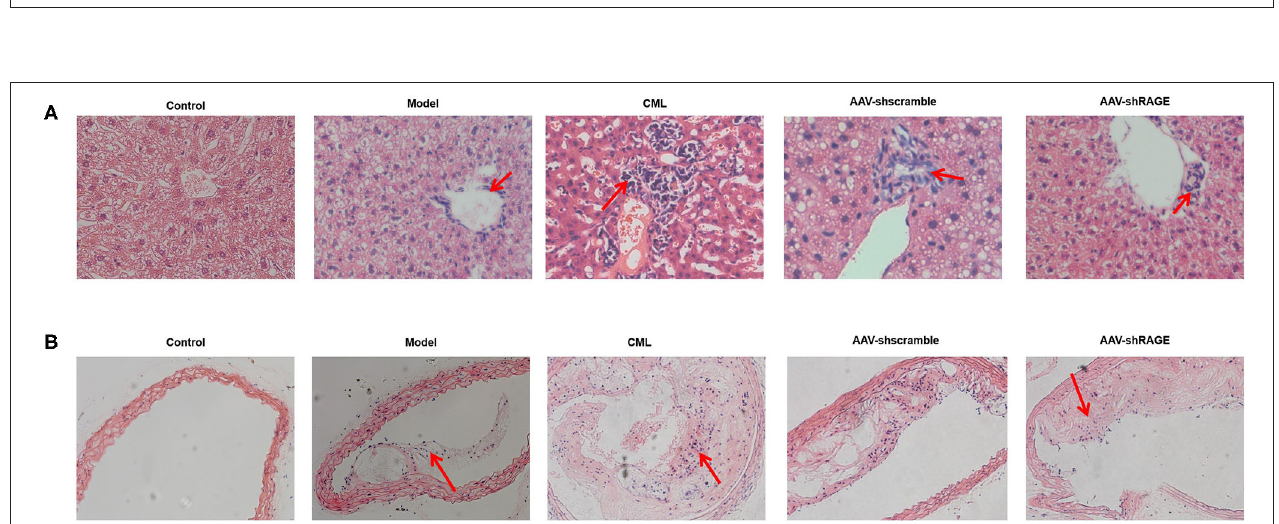
FIGURE 7 | CML increases the density of inflammatory cells infiltrating the plaque and liver (A) H&E staining of ApoE − / − mice liver ( × 200) (B) H&E staining of ApoE − / − mice aotra plaque ( × 200).The red arrow points to the location of inflammatory cell infiltration.